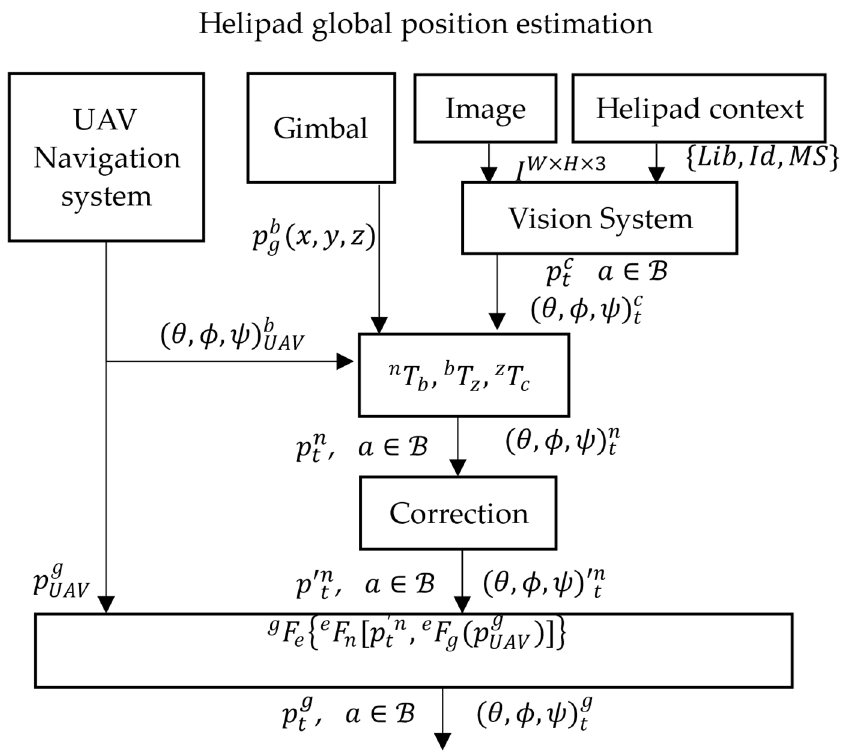
Figure 5. Helipad global position estimation